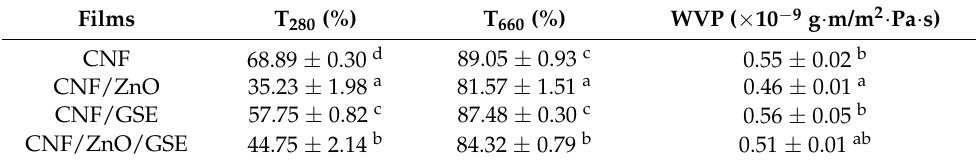
Figure 4. ( a ) The visual appearance photos and ( b ) UV–Vis spectra of CNF/ZnO/GSE films. Table 1. Light transmittance and water vapor permeability of CNF/ZnO/GSE films